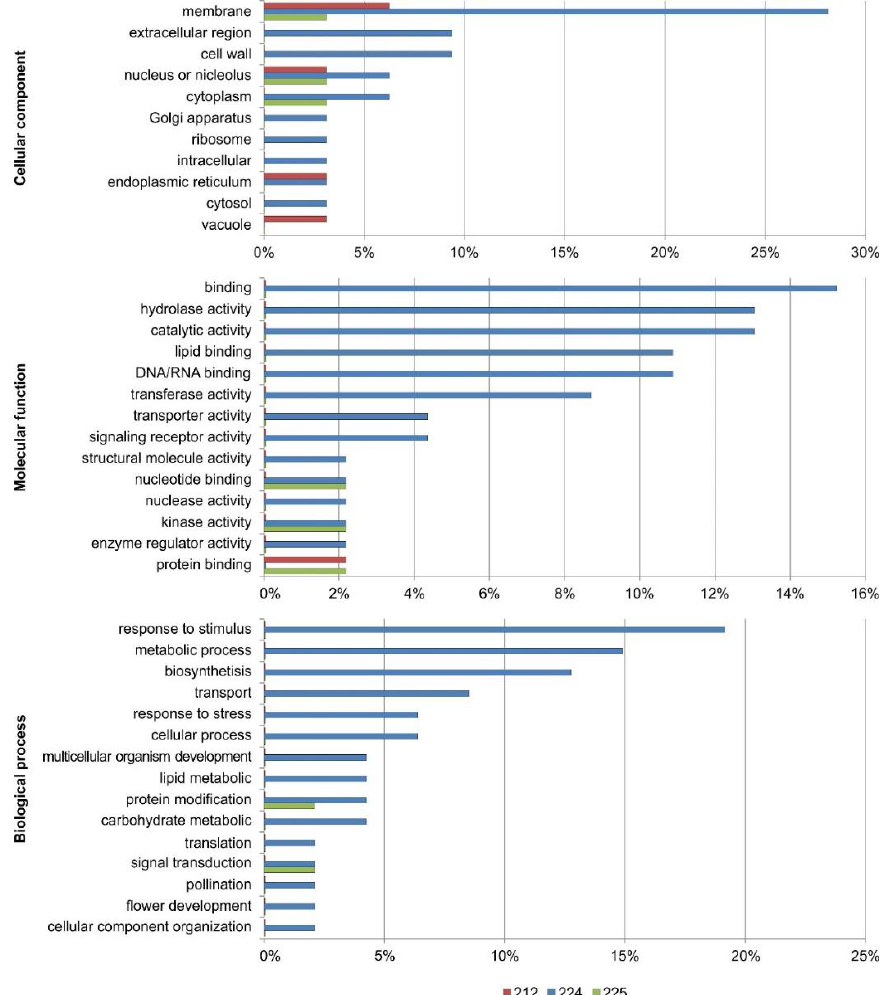
Figure 4. Percentages of GO terms assigned to different functional groups under biological process, cellular component and molecular function categories.